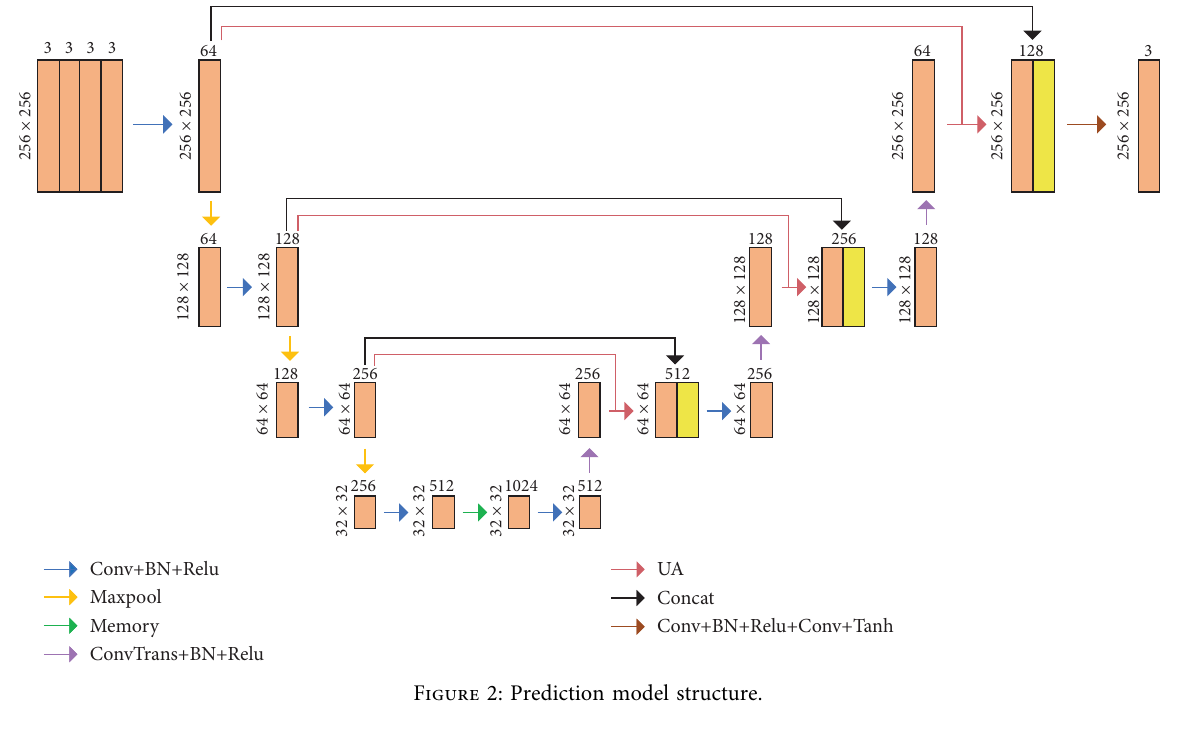
Figure 2: Prediction model structure.